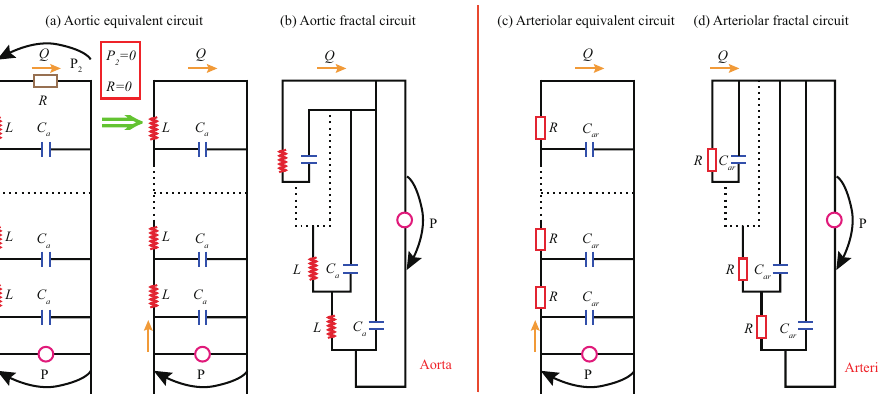
Figure 3. Infinite-level self-similar and fractal functional circuit, i.e., the infinite-level self-similar functional circuit model (ISFCM), of the aorta and arteriole, respectively: ( a ) Aortic equivalent